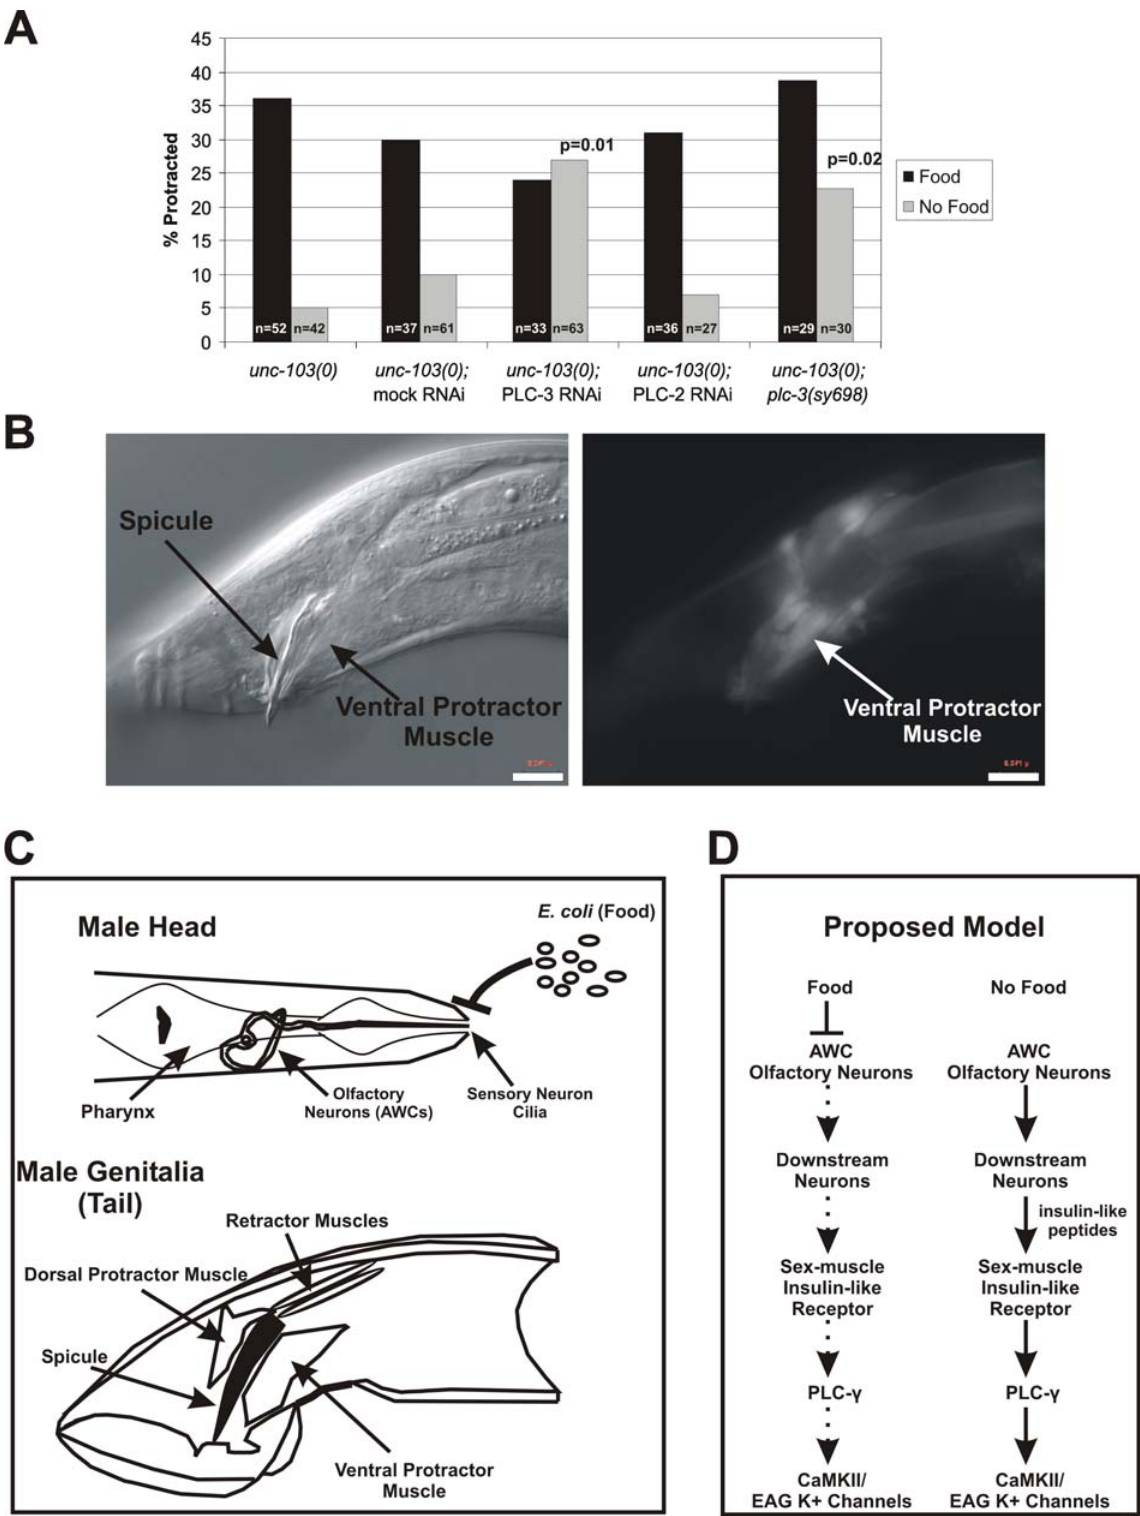
Figure 5. Phospholipase C-gamma (PLC-3) is required for food-deprivation suppression of unc-103(0) -induced muscle seizures. (A) Graph displaying the effects of PLC-3, PLC-2 RNAi, and plc-3(sy698) on unc-103(0) -seizure susceptibility on food and no-food conditions. p-value for PLC-3 RNAi relative to unc-103(0) Mock RNAi no-food control, p-value for unc-103(0); plc-3(sy698) relative to unc-103(0) no-food control (Fisher’s exact test). (B) Pplc-3: YFP expression pattern in young adult male. The ventral protractors are labeled. Scale bar 6 m m. (C) Cartoon displaying the relevant structures in the head and male tail. (D) Proposed model for sensory regulation of sex-muscle excitability during food-deprivation. When food odors